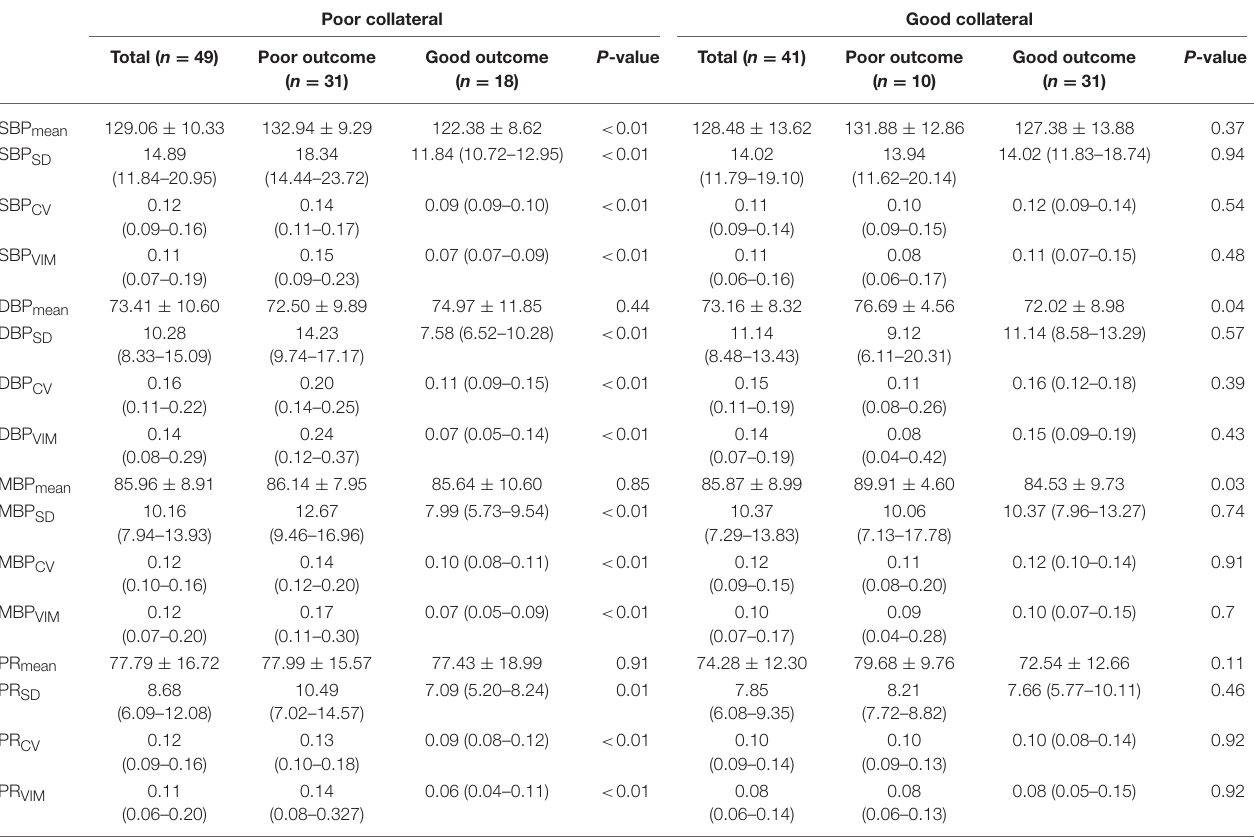
TABLE 3 | Association of blood pressure variability parameters with clinical outcomes according to the collateral status. Poor collateral